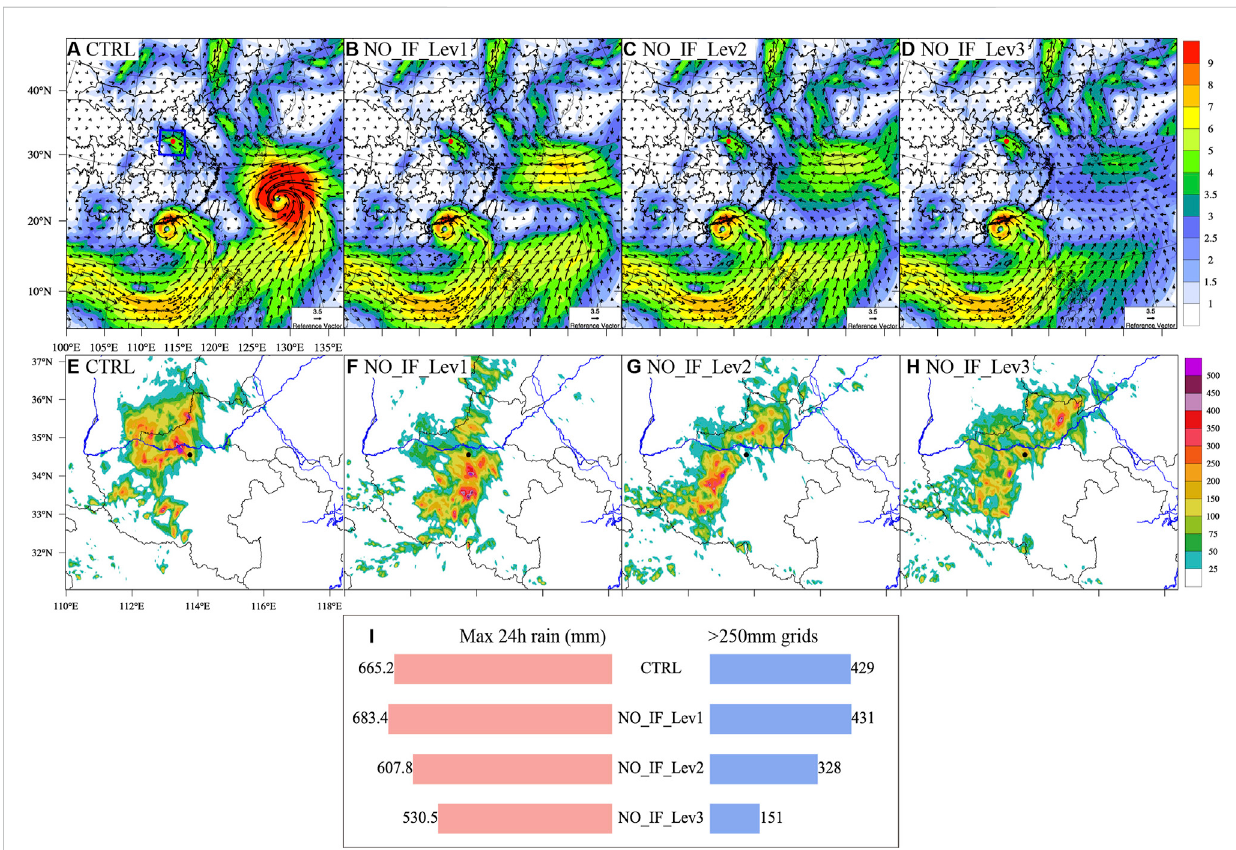
Comparison of experiments CTRL, NO_IF_Lev1, NO_IF_Lev2, and NO_IF_Lev3. (A – D) Vertically integrated water vapor fl ux (unit: 10 2 kg m − 1 s − 1 ) of the initial fi eld at 0000 UTC July 19. (E – H) 24 h precipitation (unit: mm) from 0000 UTC July 20 to 0000 UTC 21 July 2021. (I) Histograms of